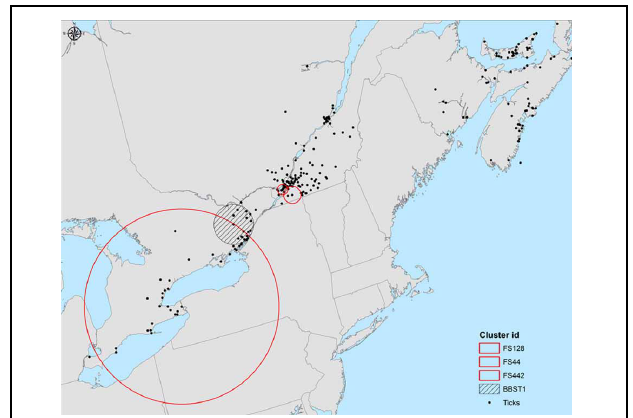
FIGURE 2 | Spatial cluster analysis of 55 haplotypes of mtDNA Cox1 sequences from Ixodes scapularis (see Mechai et al., 2013 for details) and MLST sequence types of B. burgdorferi within these ticks collected in passive surveillance in southern Canada. Three significant clusters of Cox1 haplotypes were identified respectively in south and south-western Quebec and Southern Ontario (red circles). One small-scale cluster of one B. burgdorferi ST (ST-01) was also found in south eastern Ontario (hatched circle). Because this ST has been found previously in the northeastern US, and because of the small radius of the cluster, this cluster likely represents a founder